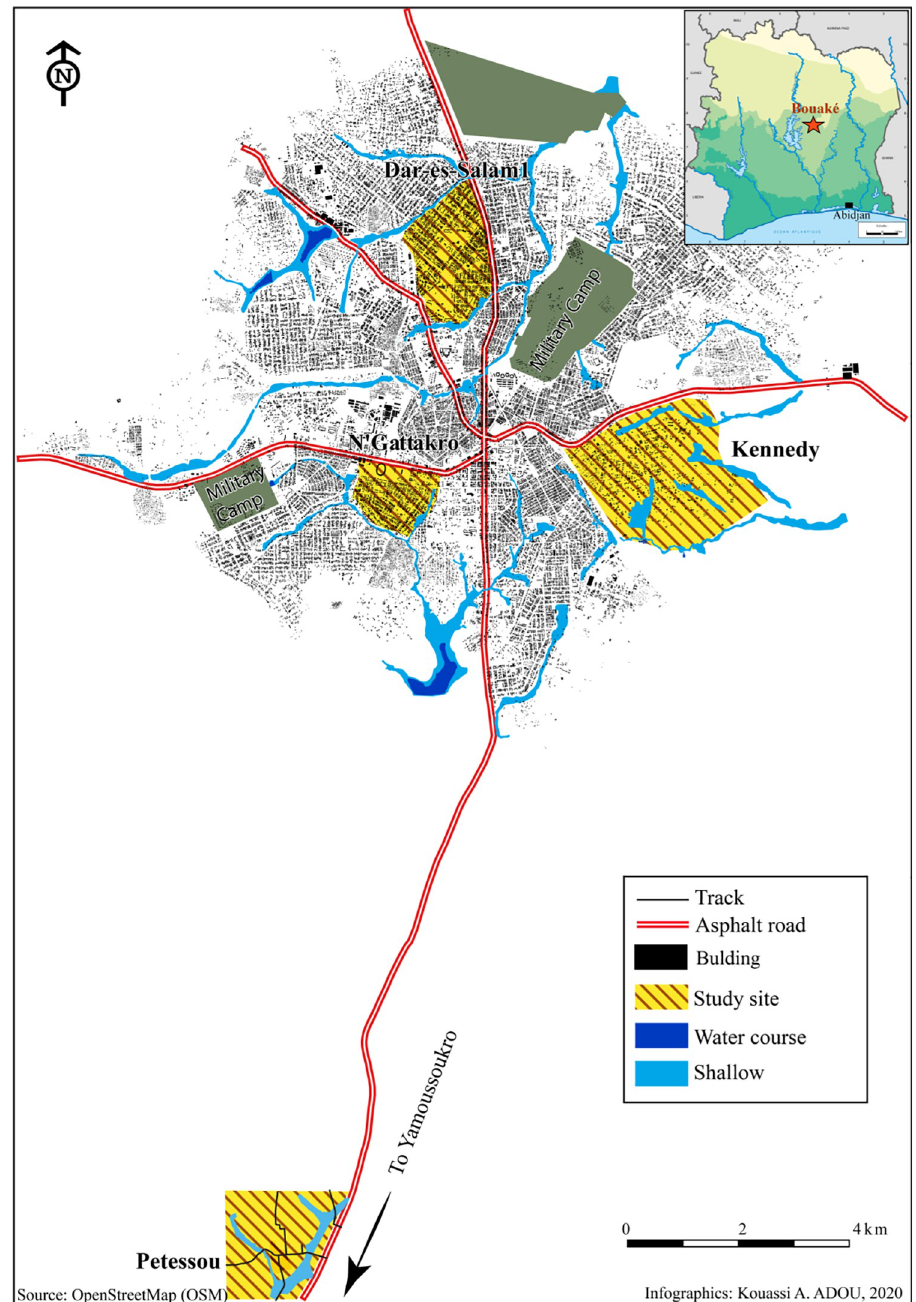
Fig 1. Map of study areas in the city of Bouake´, Coˆte d’Ivoire. Different study sites are hatched. Map source: https:// www.openstreetmap.org/export#map=12/7.6821/-5.0039.